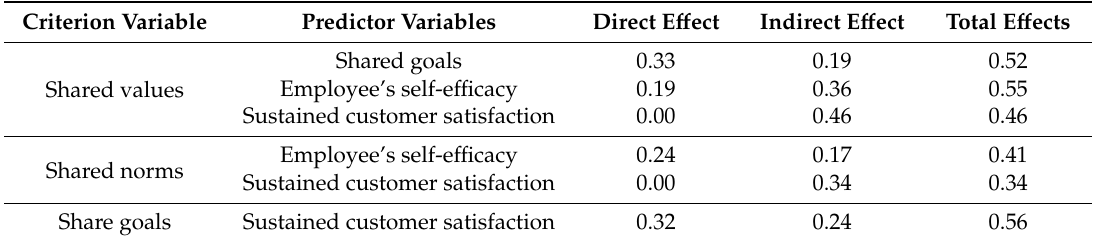
Table 6. Direct, indirect, and total e ff ects among research